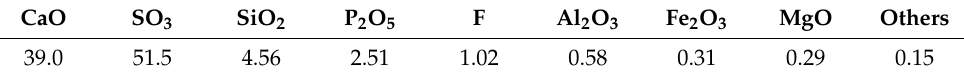
Table 1. Chemical composition of the phosphogypsum (wt.%).